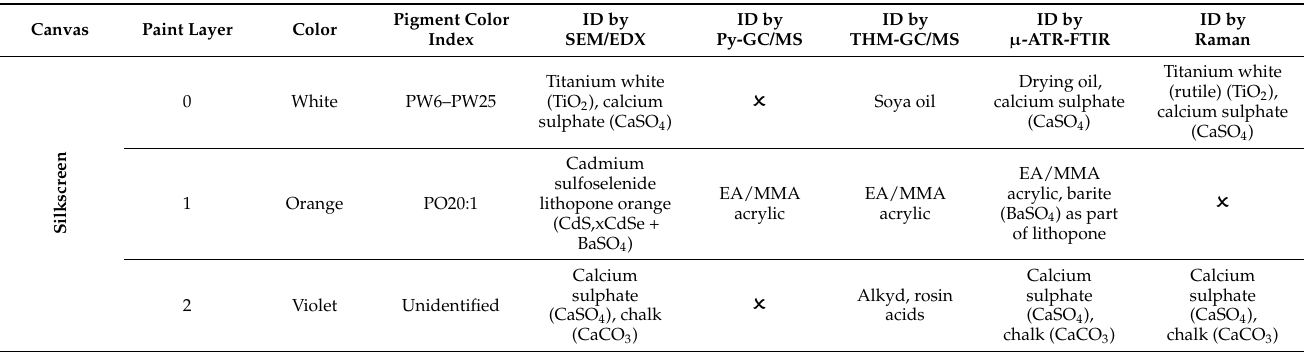
Table 4. ID of the main components identified for each layer of the silkscreen canvas by Andy Warhol by different analytical techniques.